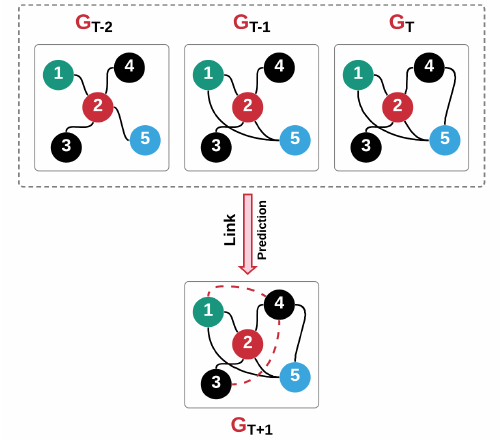
Figure 6. Priodic link prediction: The inputs are graph snapshots in different time intervals